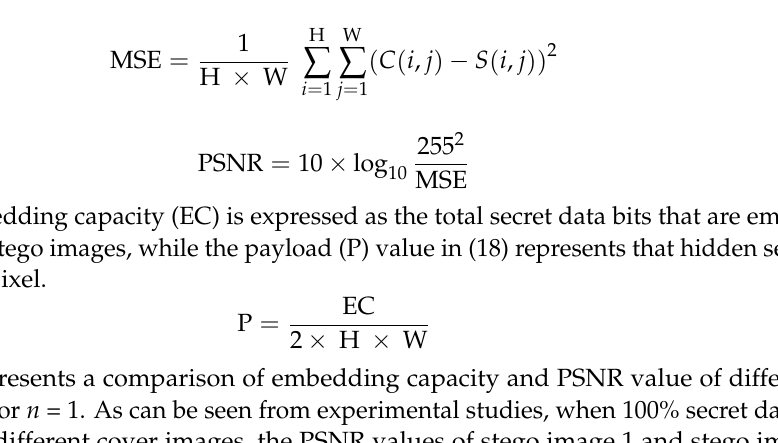
Figure 6. The flow chart of the data extraction process. ( a ) Lena; ( b ) Airplane; ( c ) Peppers; ( d ) Baboon. The PSNR value is utilized to measure the similarity between the original cover image and the stego image. The higher this value, the better the stego image quality. Formulas showing the calculation of the mean square error (MSE), which is between the original cover image and the stego image, and PSNR values are calculated in (16) and (17), respectively. The H and W values represent the size of the cover image in